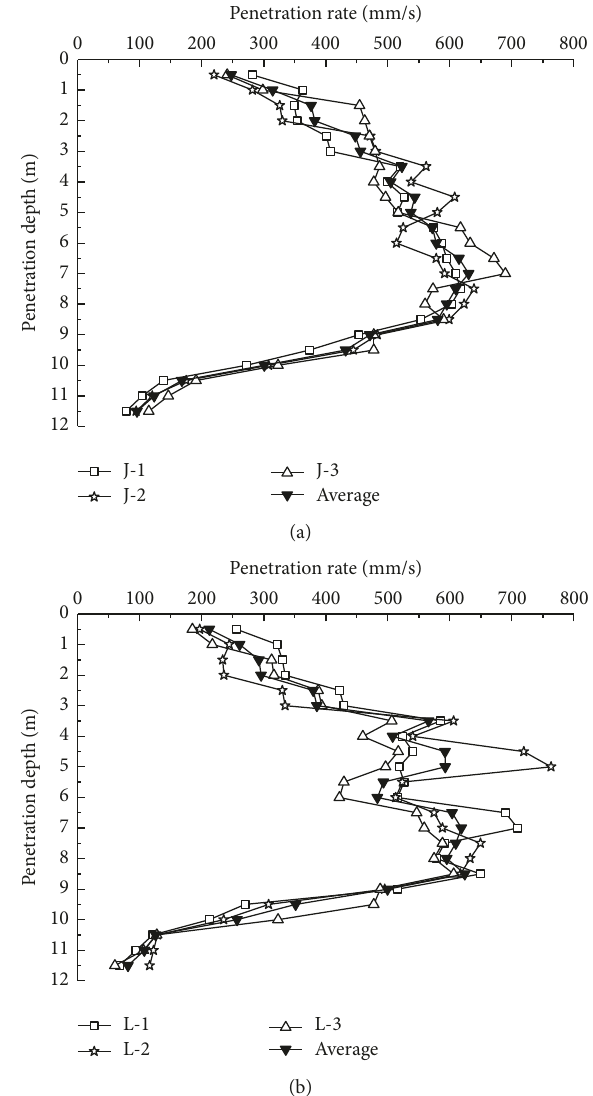
Figure 9: Penetration rate of piles in series J and series L versus penetration depth: (a) operated by the skilled operator. (b) Operated by the new